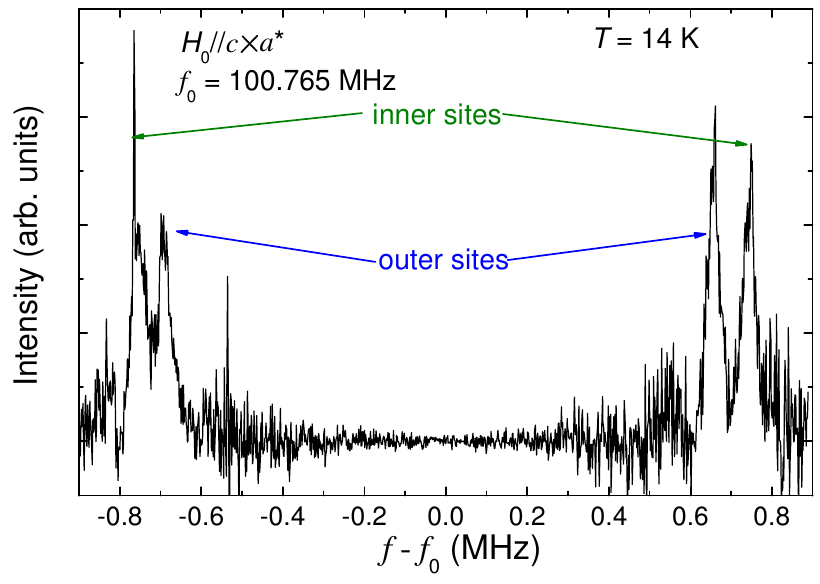
Figure 10. The NMR spectra below the antiferromagnetic transition temperature at * // acH × 0